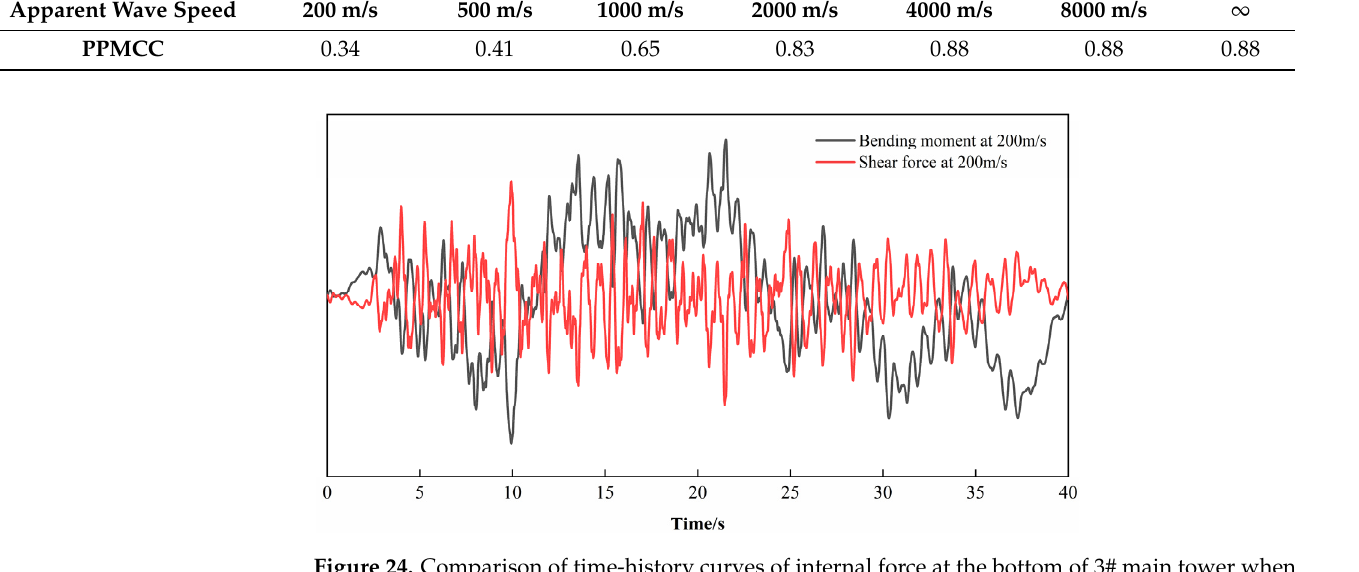
Figure 24. Comparison of time-history curves of internal force at the bottom of 3# main tower when apparent wave velocity is 200 m/s.